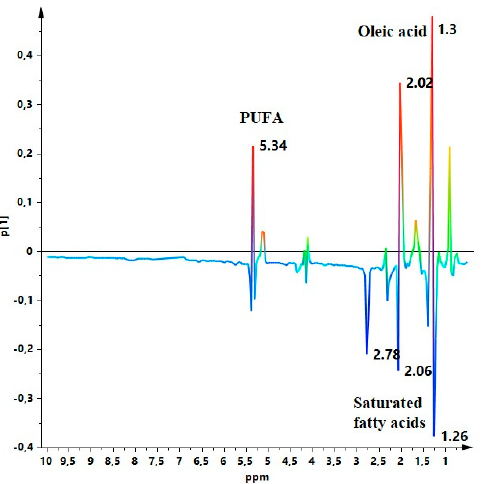
Figure 4. Line-plot of the Figure 1 PCA model for samples of considered organic EU community and non-community oils; 3 components model with R 2 X = 0.854, Q 2 = 0.773.